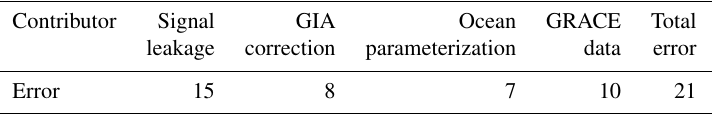
Table A1. Contribution of different error sources to the error in the total GrIS mass trend estimated from GRACE data both with and without data weighting (inGtyr − 1